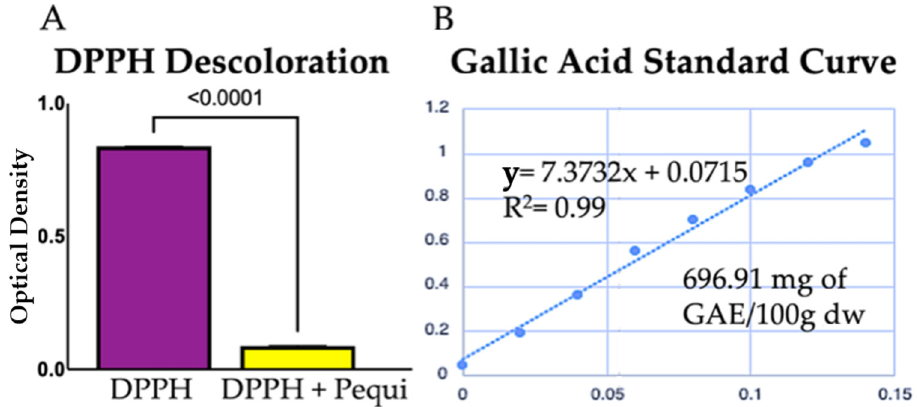
Figure 3. Pequi bark ethanolic extract is rich in phenolic compounds and scavenges free radicals in vitro: ( A ) graphic representation of DPPH reagent discoloration (92.62 ± 0.23%) as a measure for free radical neutralization by pequi extract; ( B ) gallic acid standard curve and concentration of total phenol in the extract based on gallic acid equivalence are shown. DPPH: 2,2-diphenyl-1- picrylhydrazyl.; GAE: gallic acid equivalent; dw: dry weight.